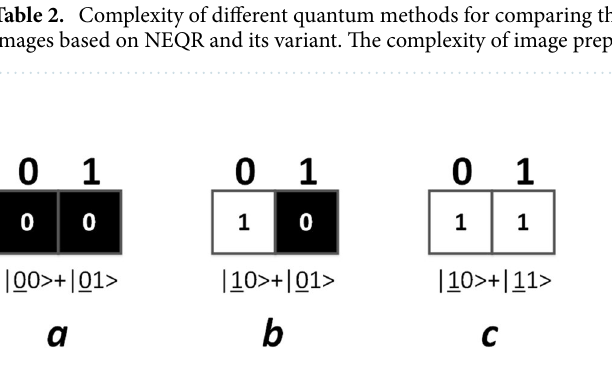
Figure 4. Three binary images used for calculating similarity. The image representation states are shown below the images. The pixel value qubits are underlined. Probability amplitudes are not given for simplification.